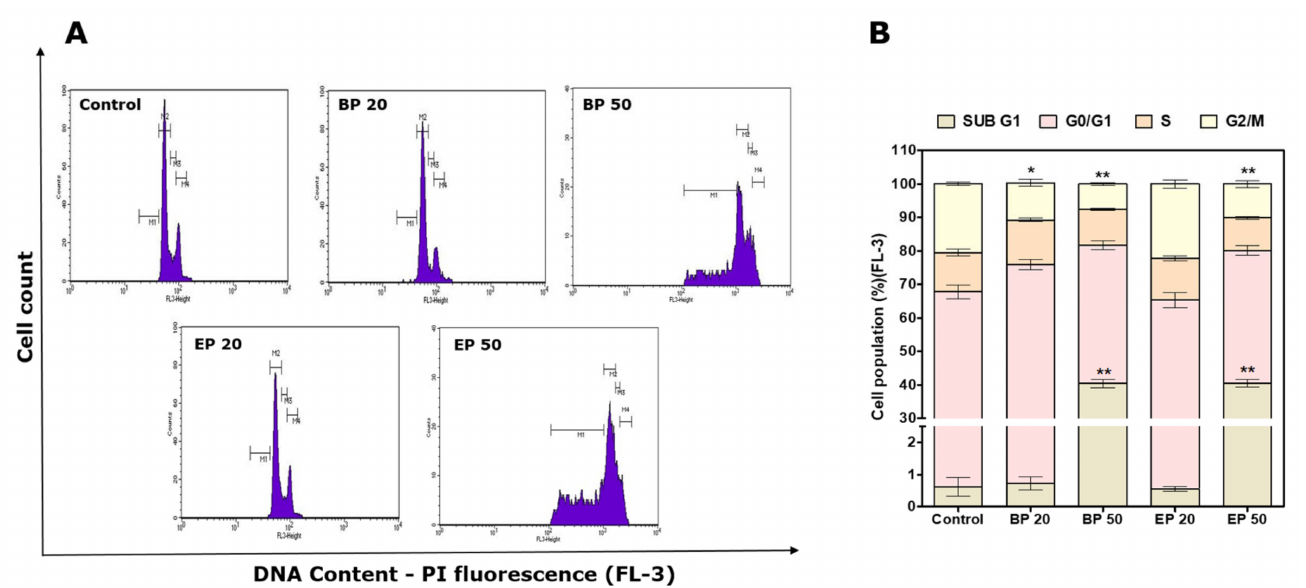
Figure 6. Cell cycle analysis by DNA content estimation with flow cytometer in HEp2 cells after treatments with BP and EP at IC 20 and IC 50 concentrations for 48 h. ( A ) Histograms show the cell distribution in the different phases of the cell cycle. ( B ) Bar graph indicating the percentage of cells in Sub-G1, G0/G1, S, and G2/M phases, respectively. The results are expressed as mean ± SD